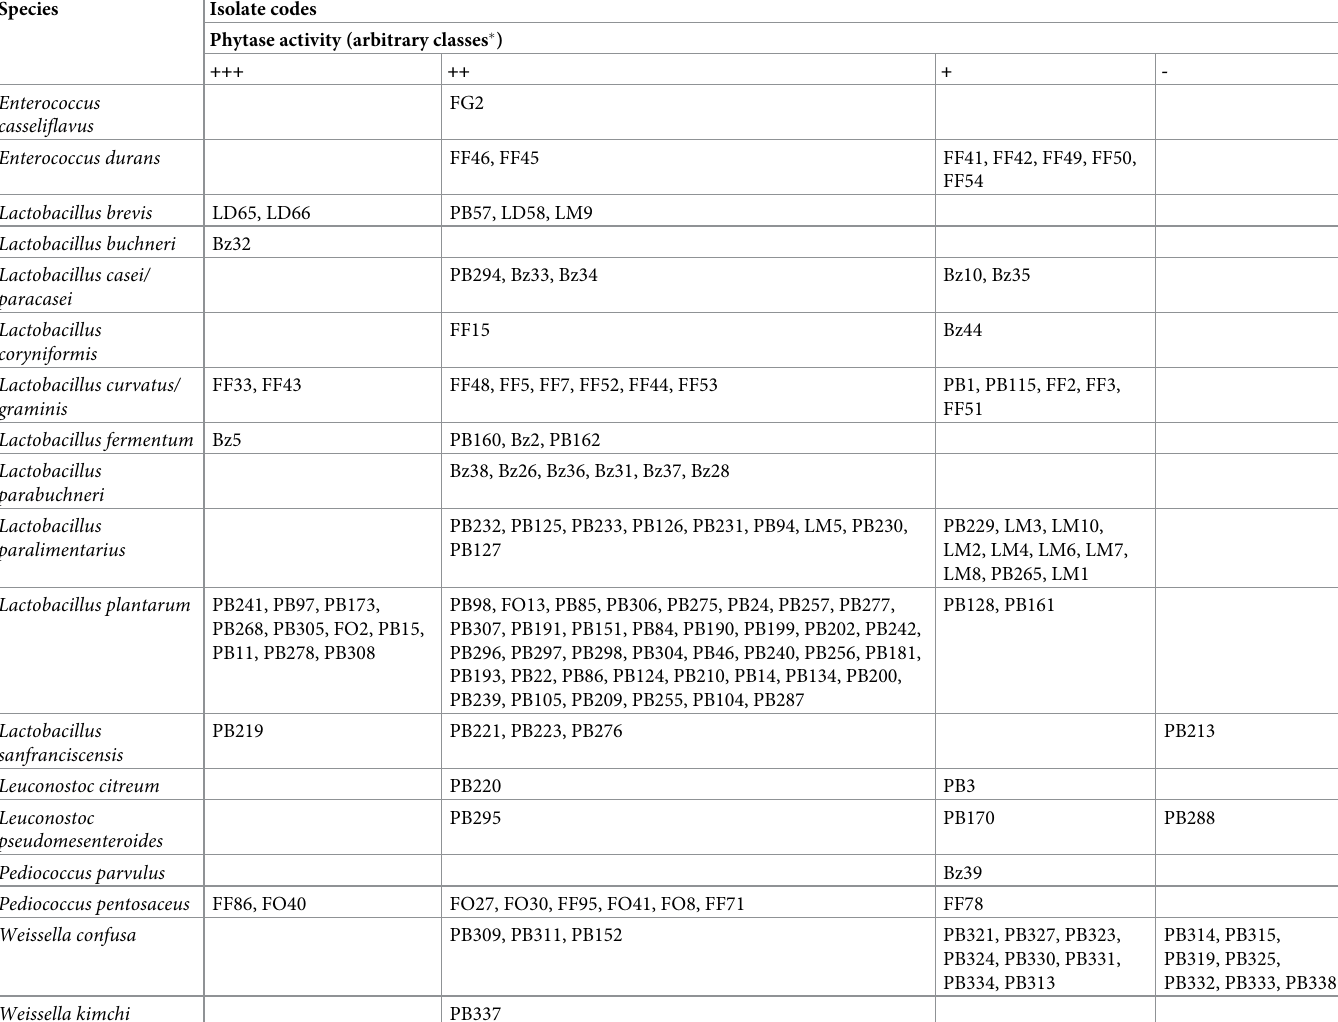
Table 2. Phytase activity of lactic acid bacteria (LAB) isolates determined using phytase plate assay.